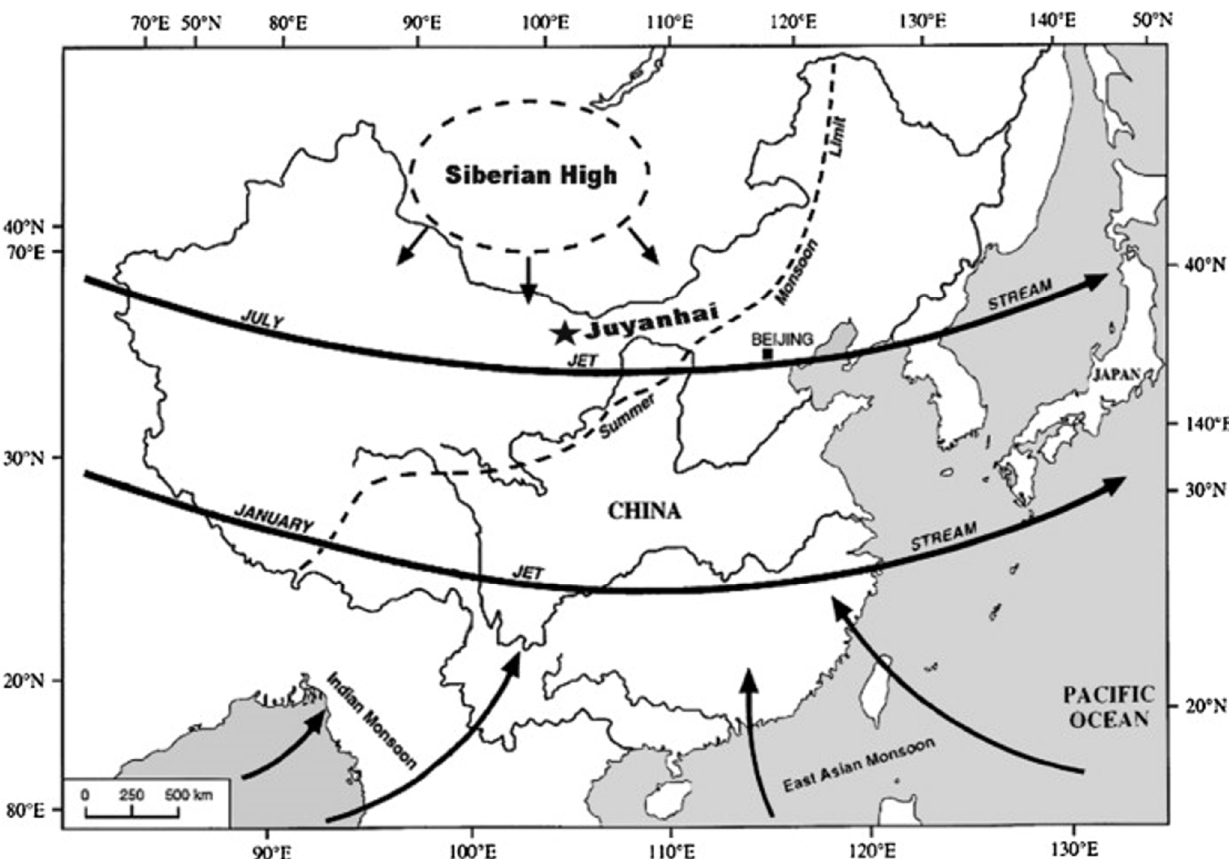
Figure 9. The geographical locations and relationship between the westerlies and the Asian Summer Monsoon. When the Asian summer monsoon is enhanced in summer, the westerly jet moves northward. When the Siberian High is enhanced in winter, the jet moves southward (revised from [14,50,75]).